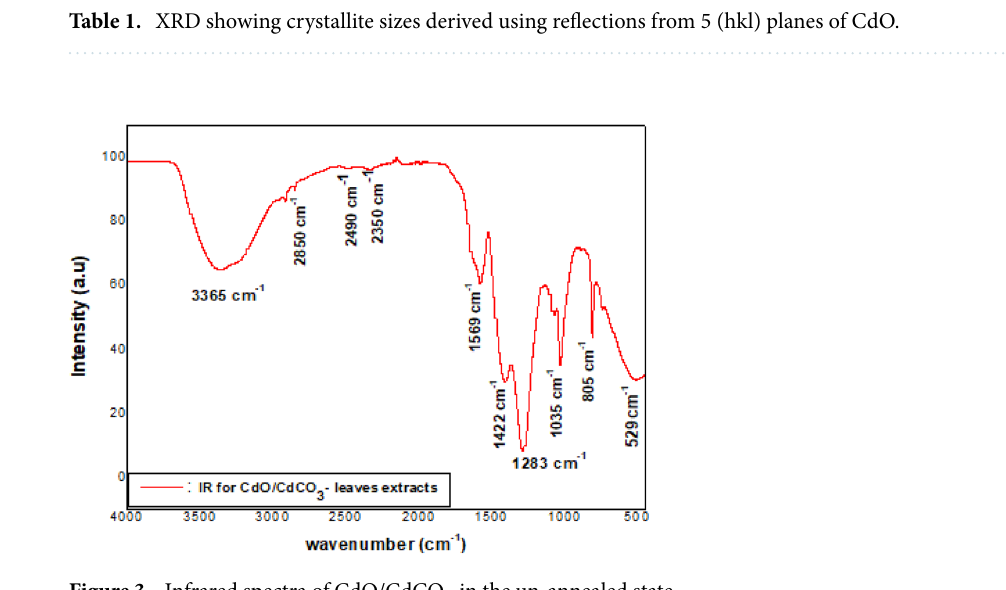
Figure 3. Infrared spectra of CdO/CdCO 3, in the un-annealed